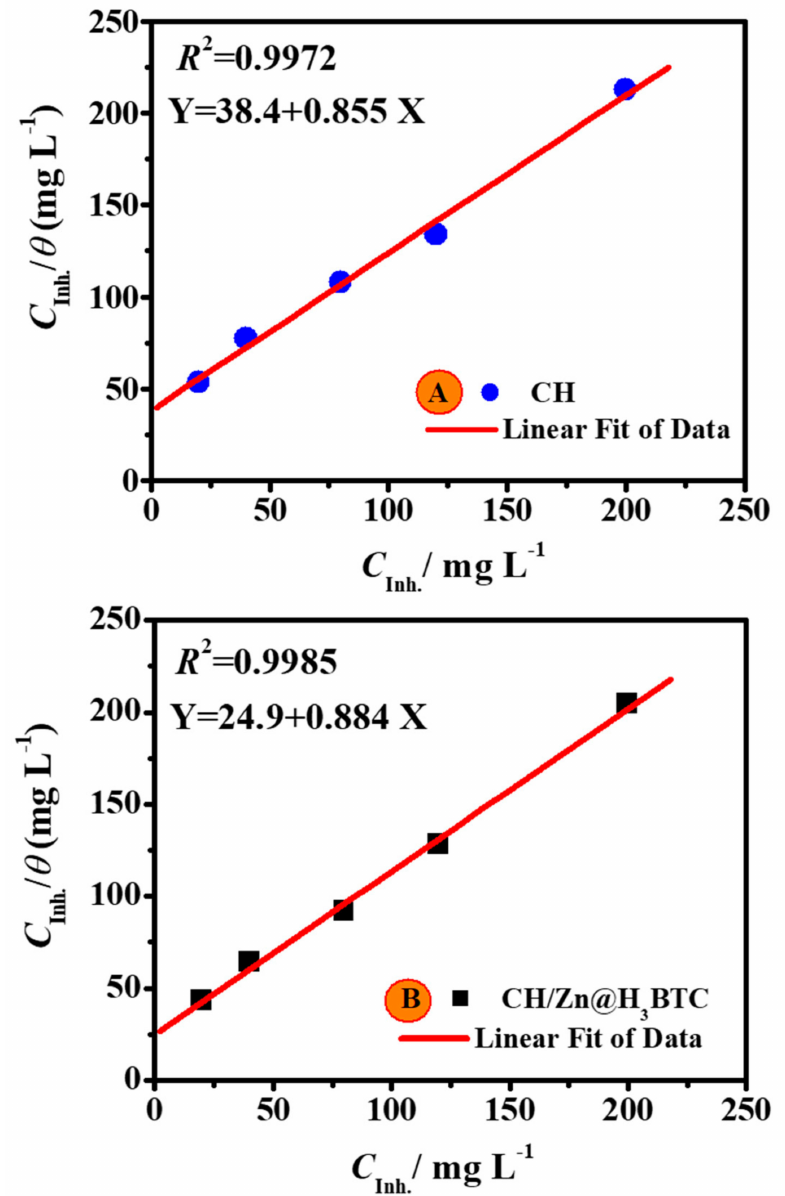
Figure 11. Plots of the Langmuir isotherm extracted from Tafel plots at 323 K in 2.0 M H 2 SO 4 with and without various concentrations of ( A ) CH and ( B ) CH/Zn@H 3